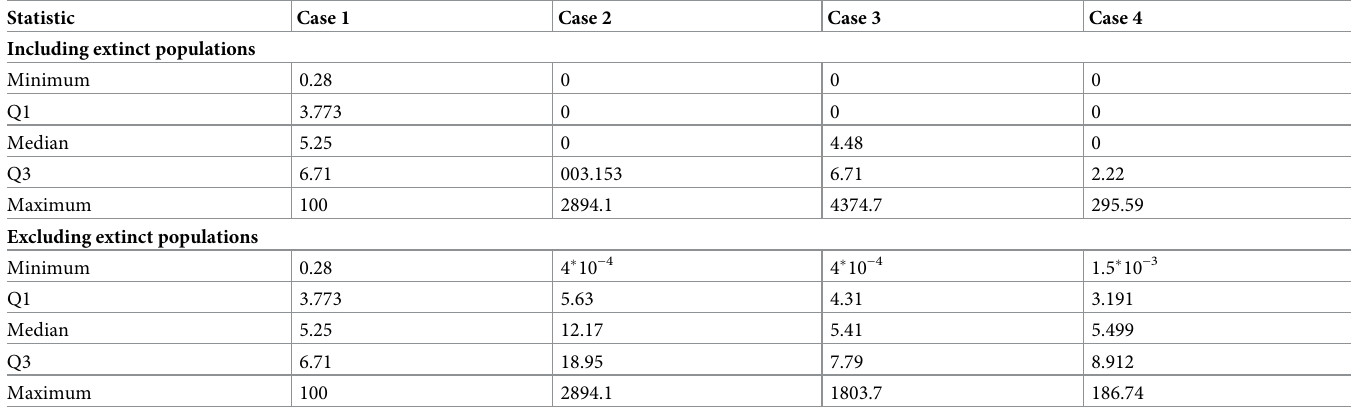
Table 2. Statistics summarising all of the simulations used for Fig 4 divided according to the cases and extinction status after the management on the threats.